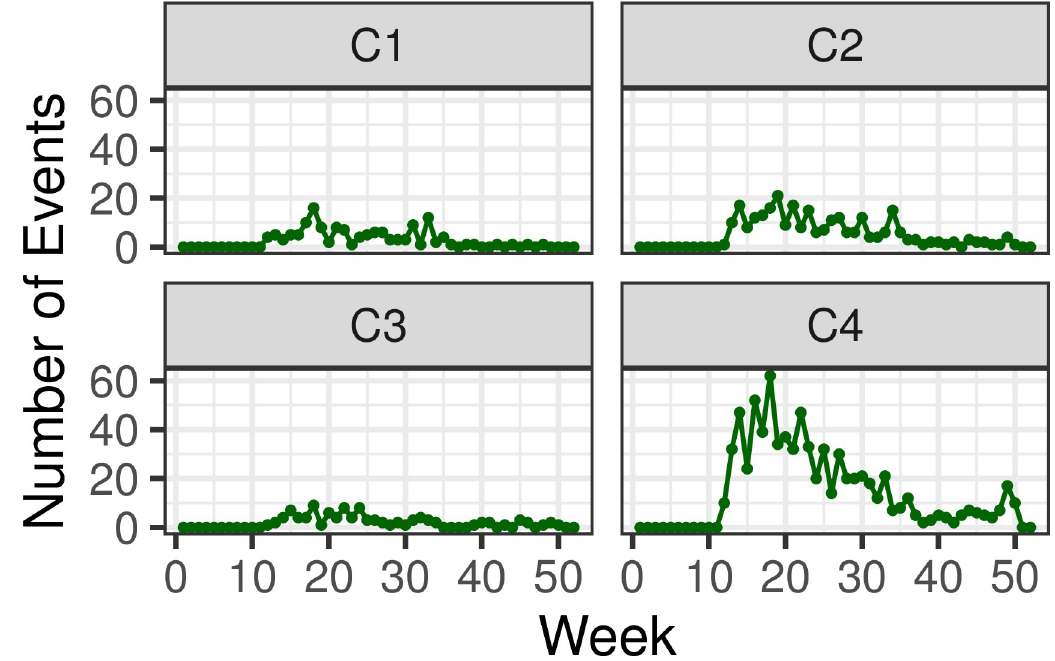
Fig 11. Weekly time series of disorder events { n j } visualized by cluster, in Mexico. Weeks are marked from week j = 1 (December 29 th 2019 to January 4 th 2020) to week j = 50 (December 6 th to December 12 th 2020).